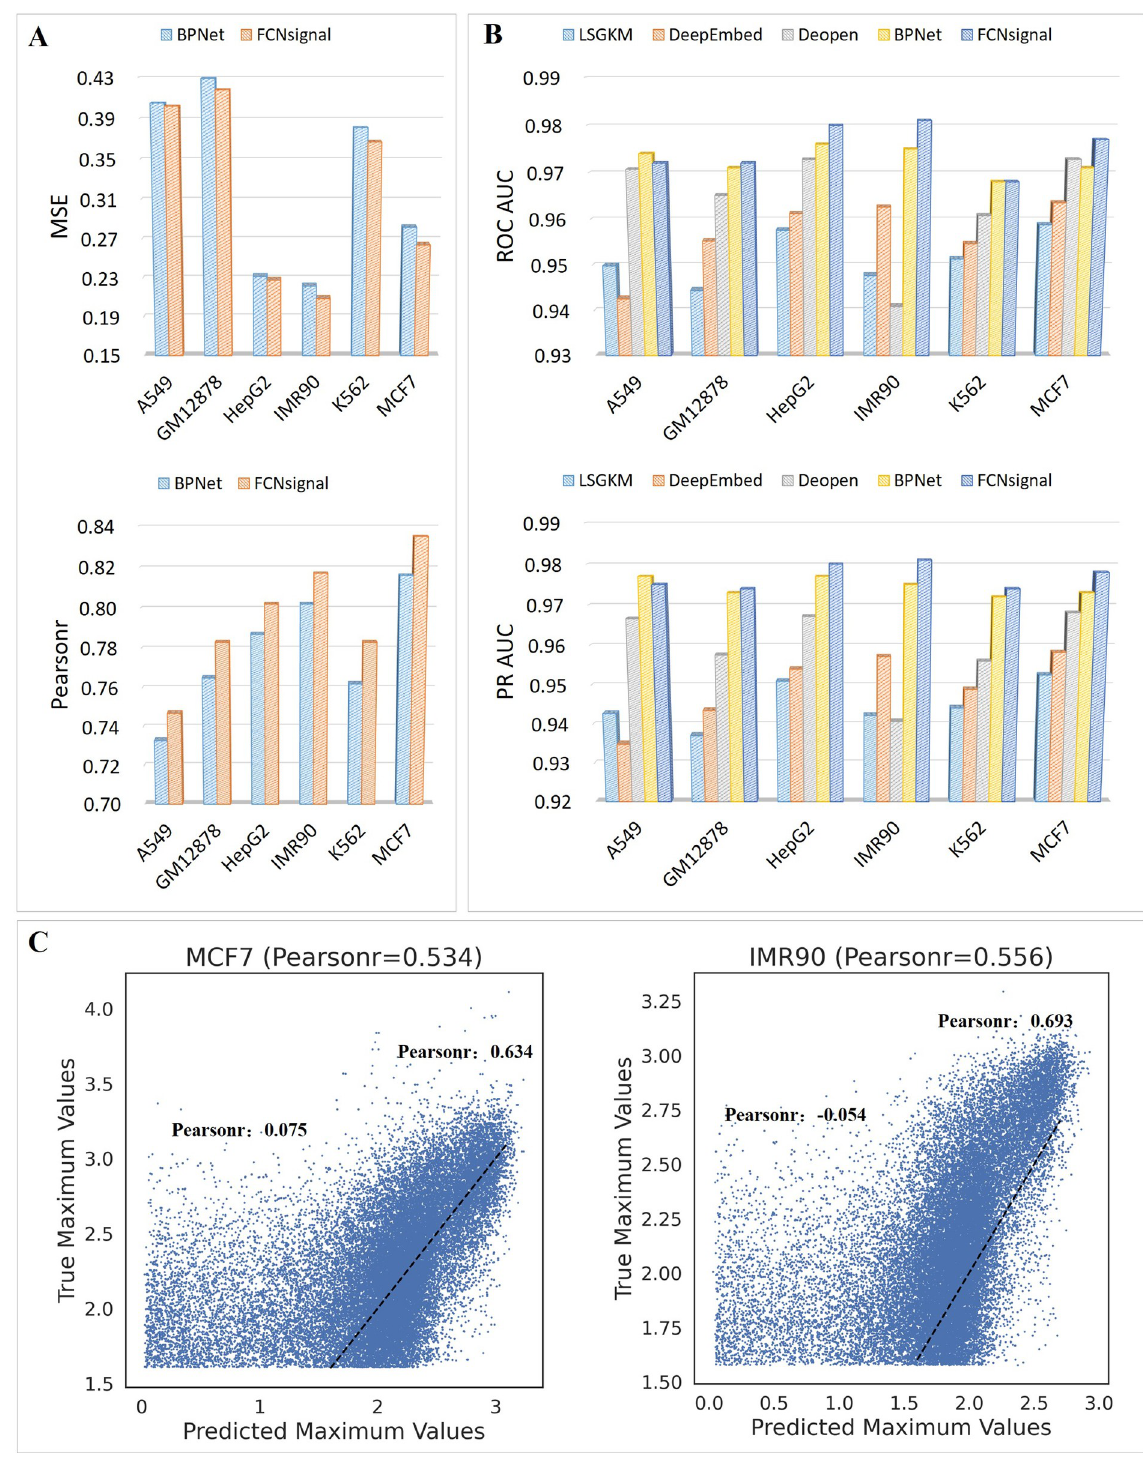
Fig 5. Performance comparison of FCNsignal and the competing methods on the six ATAC-seq datasets. (A) The MSE and Pearsonr values for BPNet and FCNsignal. (B) The AUC and PRAUC values for LSGKM, DeepEmbed, DeopenBPNet, and FCNsignal. (C) The Pearsonr between predicted maximum signals and true maximum signals for MCF7 (Pearsonr: 0534) and IMR90 (Pearsonr: 0.556). For MCF7, the Pearnsonr for DNA sequences with low and high openness are 0.075 and 0.634 respectively. For IMR90, the Pearnsonr for DNA sequences with low and high openness are -0.054 and 0.693